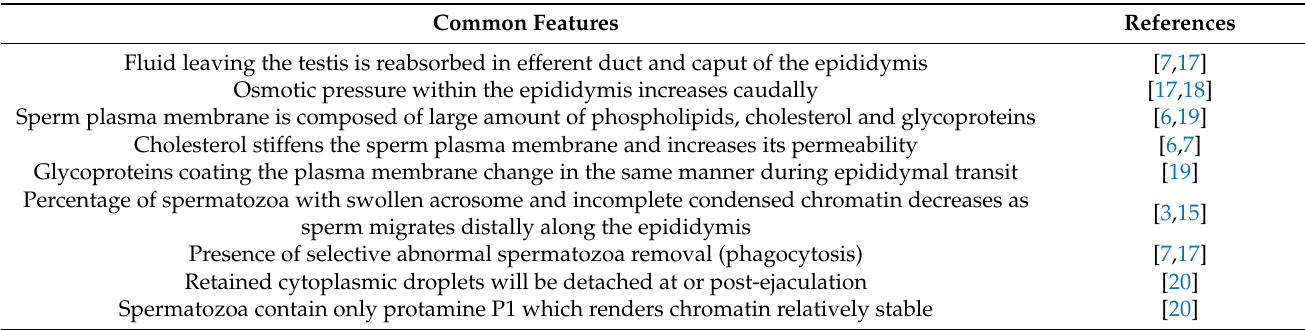
Table 2. Common features of epididymal sperm maturation in dogs and